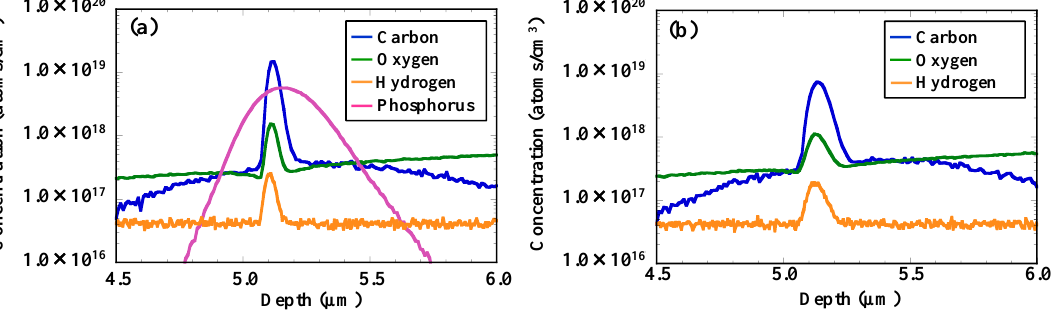
Figure 9. SIMS depth profiles of concentration of ( a ) CH 2 P- and ( b ) C 3 H 5 -molecular-ion-implanted regions after epitaxial growth.